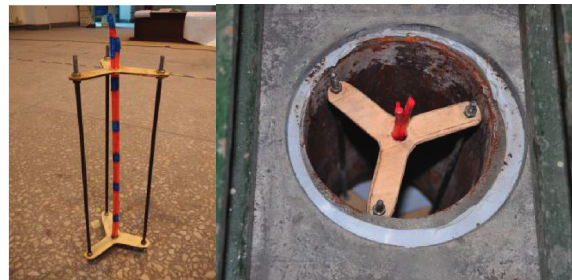
Figure 15: Schematic diagram of charge structure. Table 3: Boundary static loads of test